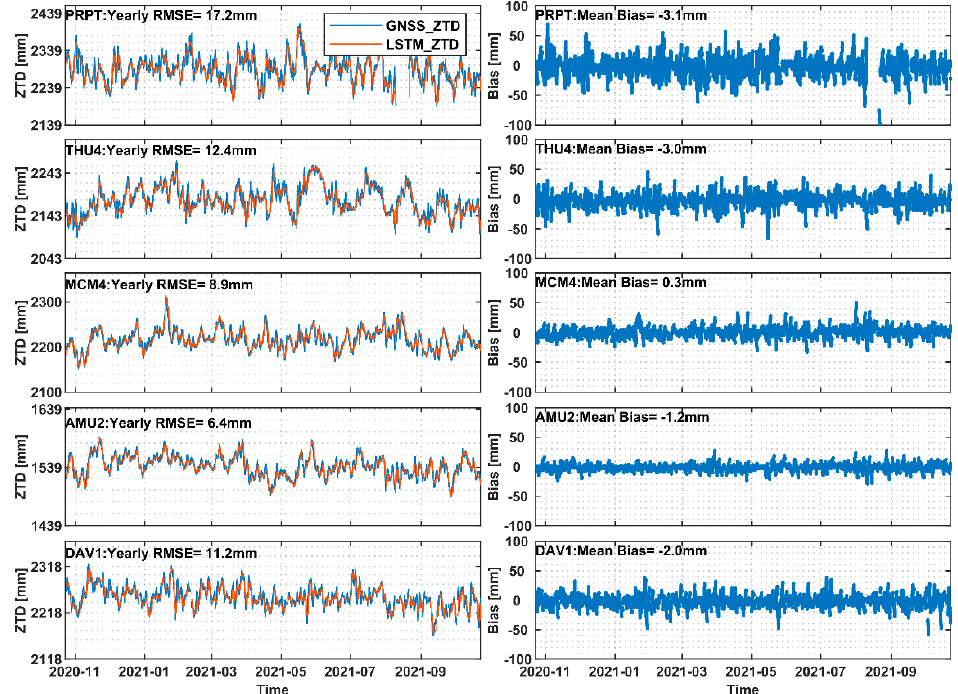
Figure 11. Comparison between LSTM_ZTD and GNSS_ZTD from 24 October 2020 to 23 October 2021 at PRPT, THU4, MCM4, AMU2 and DAV1 station.